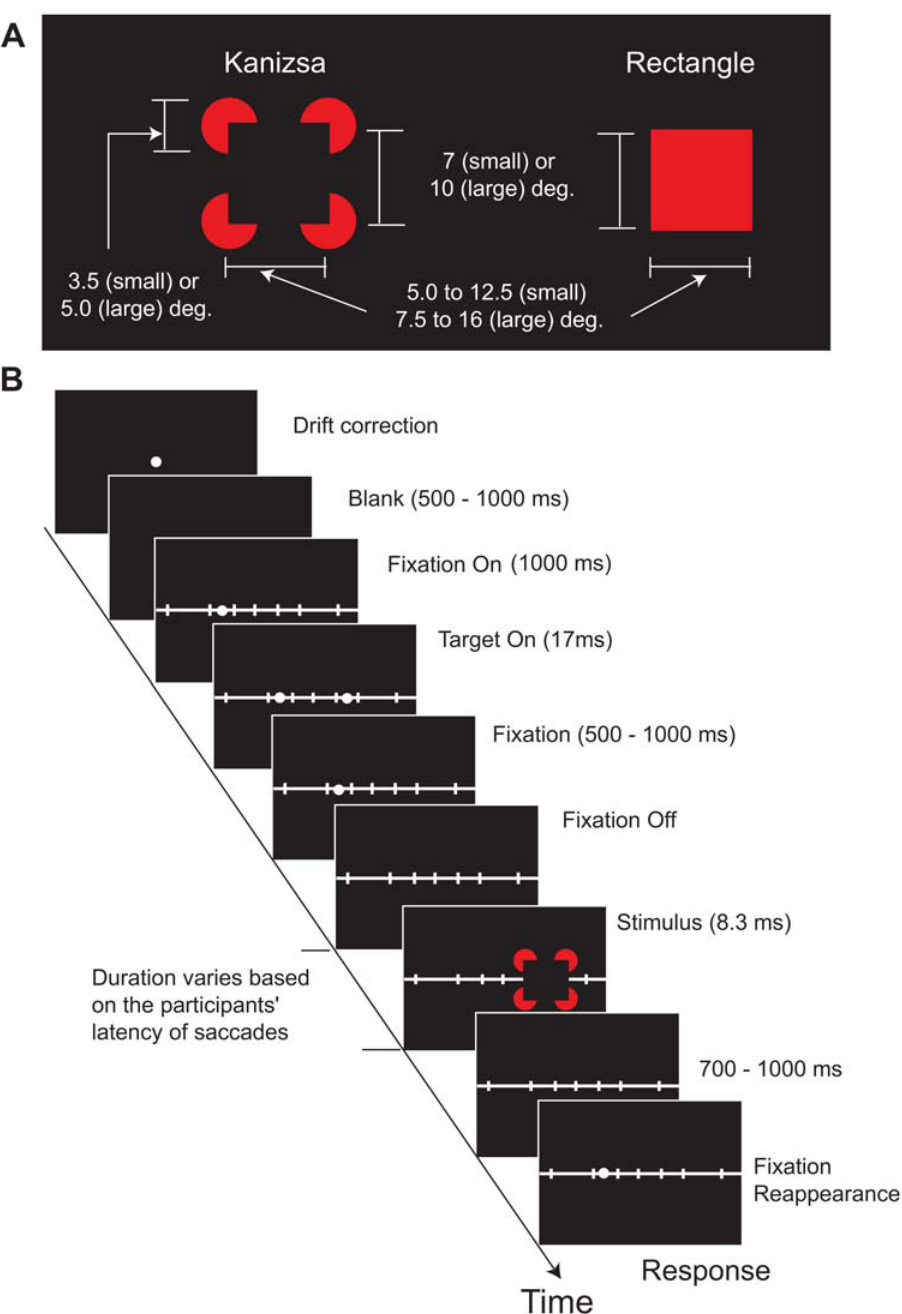
Figure2. Experiment 1A: Trial design. Panel A showsexamples of Kanizsaandrectanglestimuli. PanelB showssequence of eventsduringeach trial.